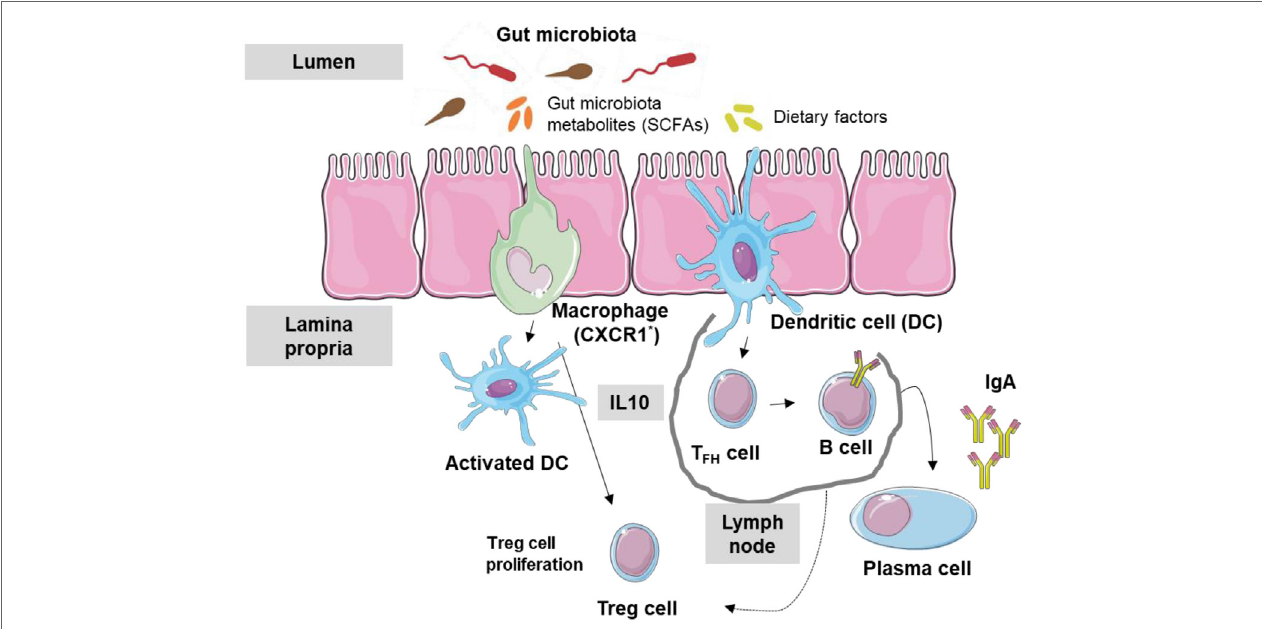
FiGURe 1 | Interaction between gut microbiota and immune system. Gut microbiota metabolites and dietary factors constitute the main antigen load of the gastrointestinal tract. Macrophages (CXCR1 + ) and dendritic cells (DCs) are stimulated and T regulatory (Treg) cells are activated by metabolic products such as short chain fatty acid (SCFA). Follicular T cells activate B cells inducing the production of IgA